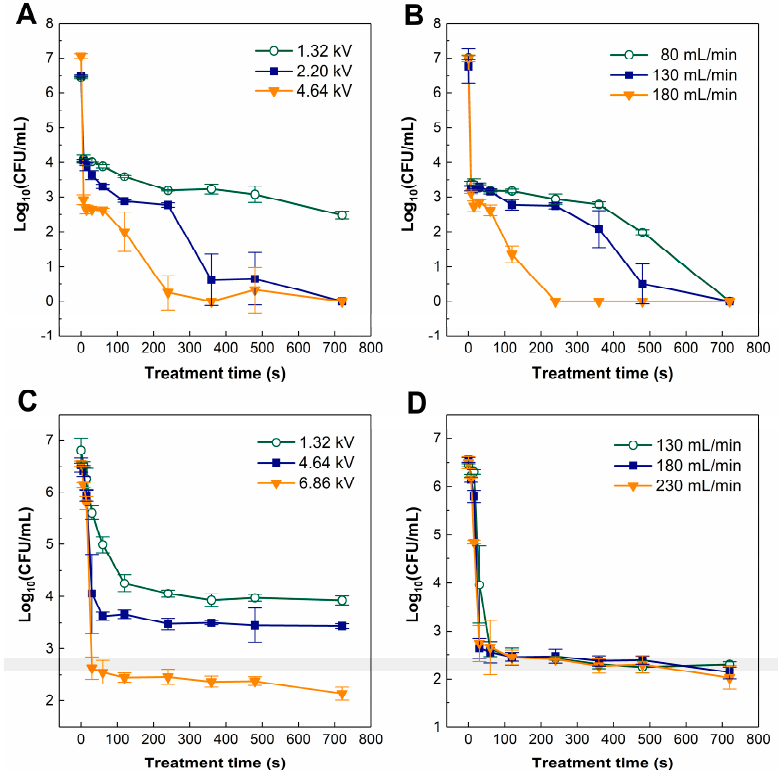
Figure 2. Survival curves of A. acidoterrestris in 0.85% saline ( A , B ) and 12% apple juice ( C , D ) treated by cold plasma with different input powers ( A , C ) and gas flow rates ( B , D ). The mean value and standard deviation calculated from three replicates are shown by each point and error bar, respectively.